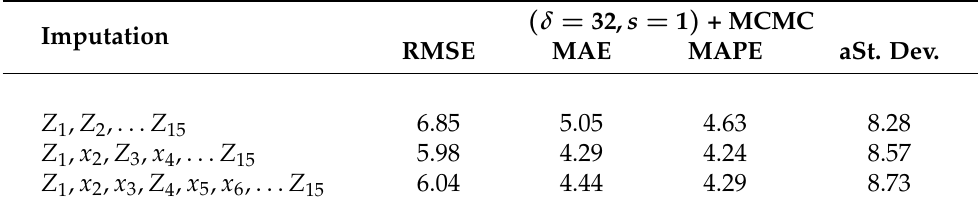
Table 2. We measure the accuracy of the prediction model under missing observations over 2 years of the test data. We denote x t as the input that is missing and Z t as the available observation. x t is calculated by fitting a linear curve between the available observations within its interval. Evaluation is done for ( L in = L out = 15 ) with ( δ = 32, s = 1 ) with MCMC inference, using 500 samples and p l = 0.4. Accuracies are calculated for the test set generated with GMM from 2008 to 2009. RMSE, MAE and aSt. Dev. values are reported in ( mm ) and MAPE in ( % )